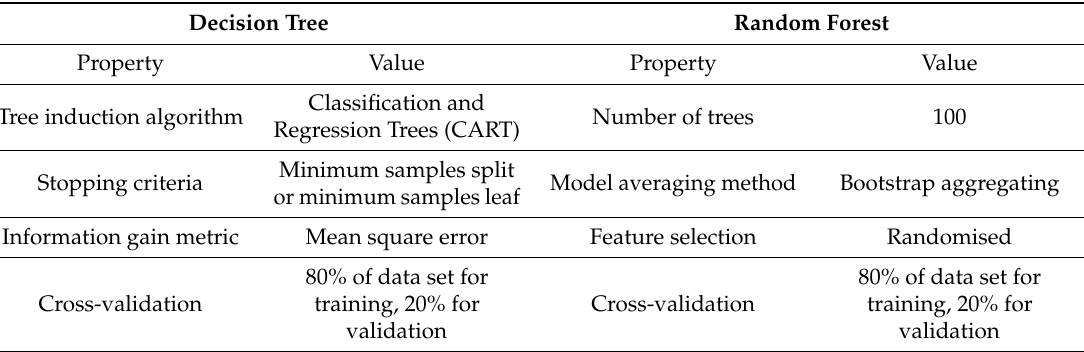
Table 1. Decision Tree and Random Forest implementation details.